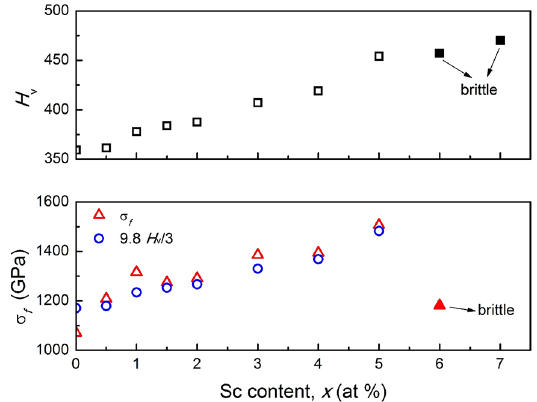
Figure 3. Vickers hardness and tensile strength values as a function of Sc content in (Al The alloys which are brittle are shown by solid